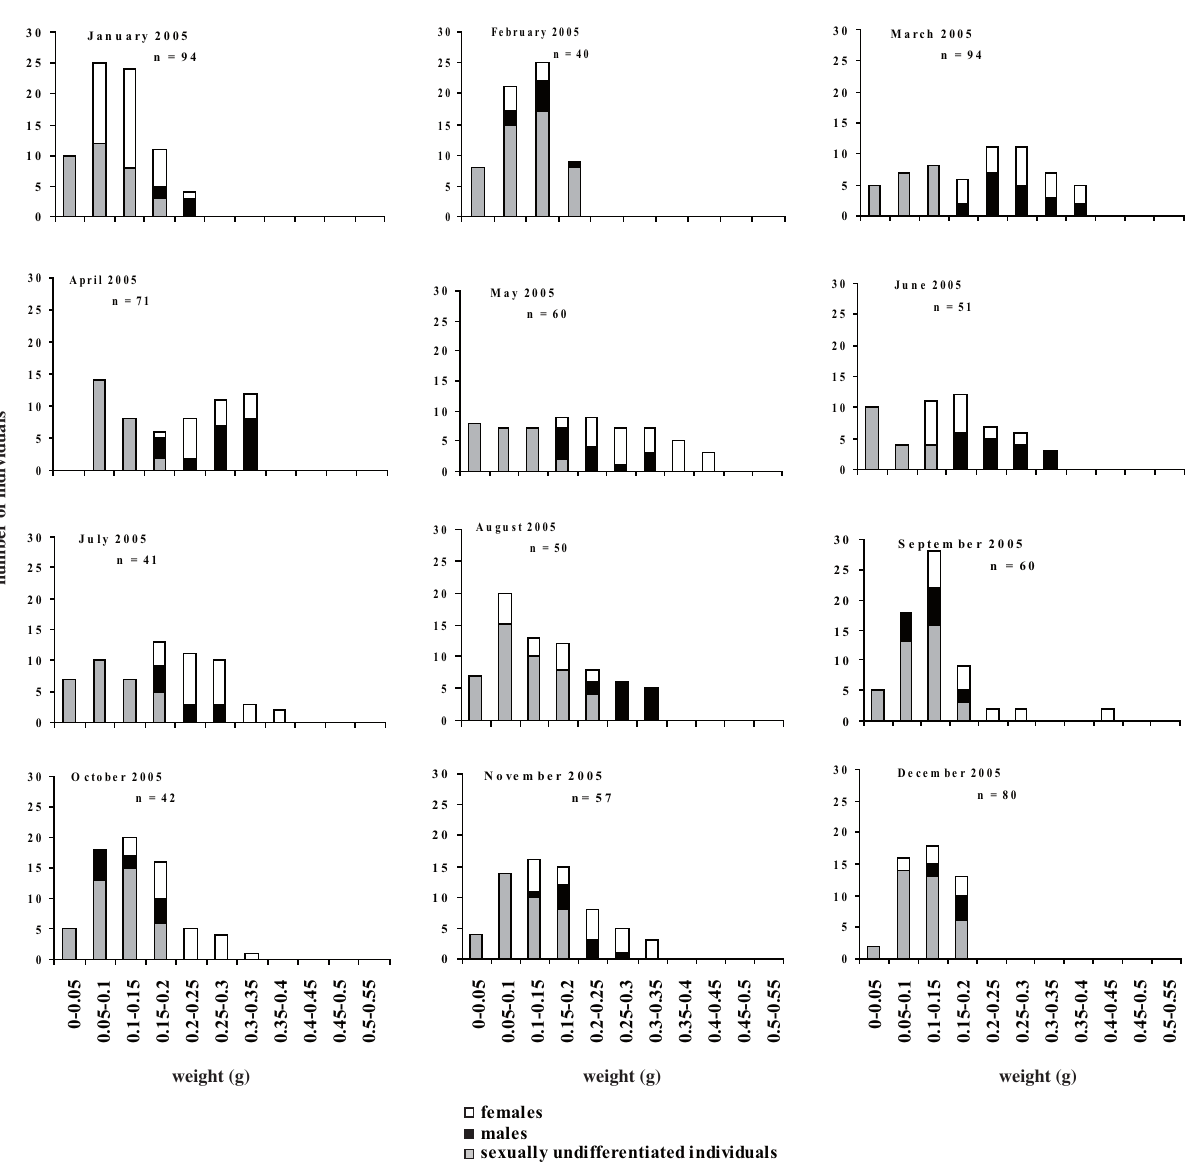
Fig . 9. – Size-frequency distribution based on whole body wet weight from January to December 2005 at